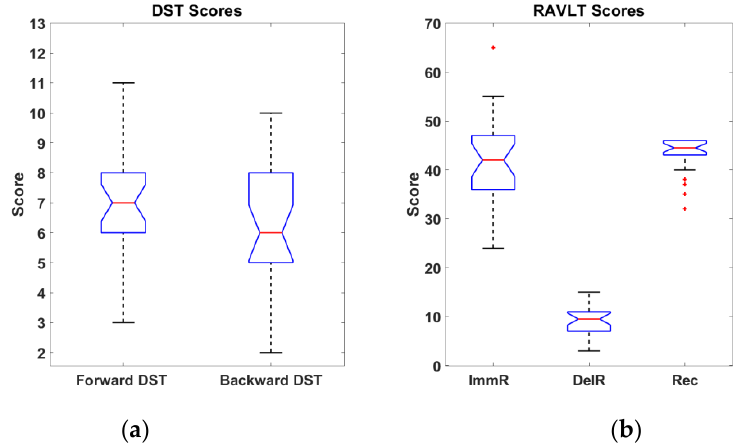
Figure 5. Whiskers plot of the participants’ scores in DST ( a ) and RAVLT ( b ). Outliers are represented with red crosses.